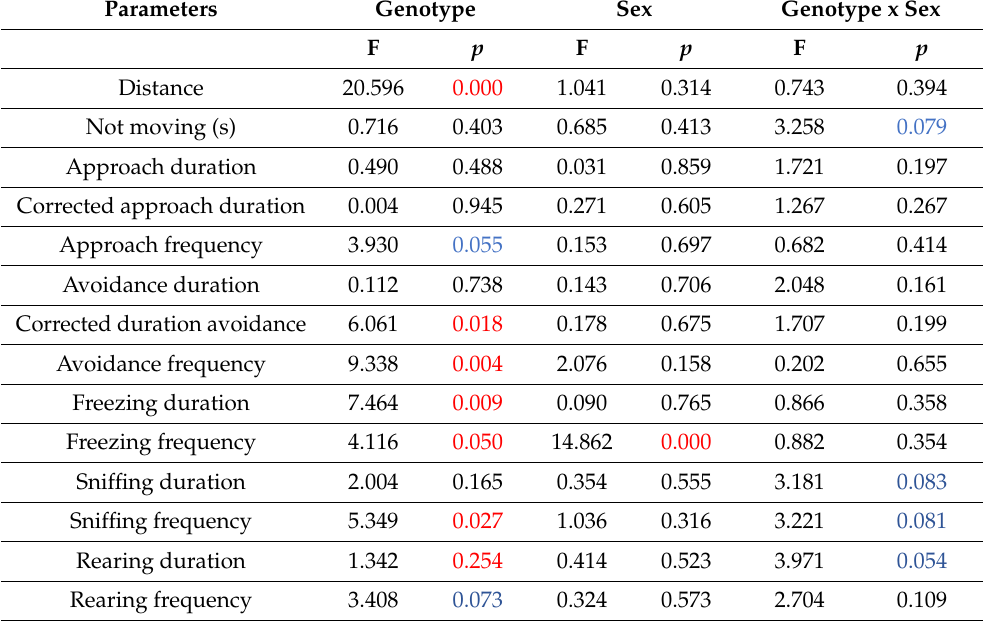
Table 2. Statistical data (results of factorial ANOVA) of fox odor test (Experiment 1). The correspond- ing data are presented on Figure 2. Parameters were analyzed by Solomon Coder by an experimenter blind to the treatment groups. Male and female control and 3xTg-AD mice age at 2-month. Degree of freedom was 1,35. Significant main effects are highlighted in red, while blue colour represents marginally significant difference.